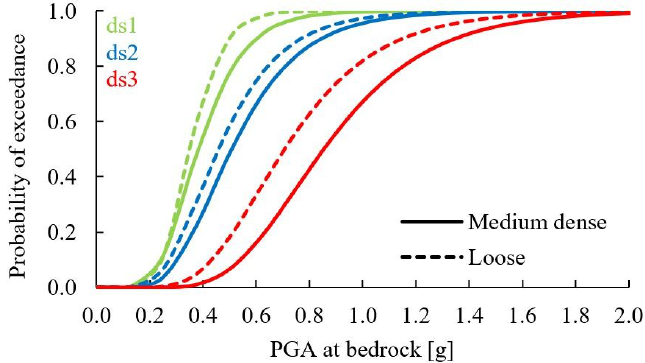
Figure 10. Influence of density of liquefiable layer on fragility curves (damage state criteria for railway embankments).